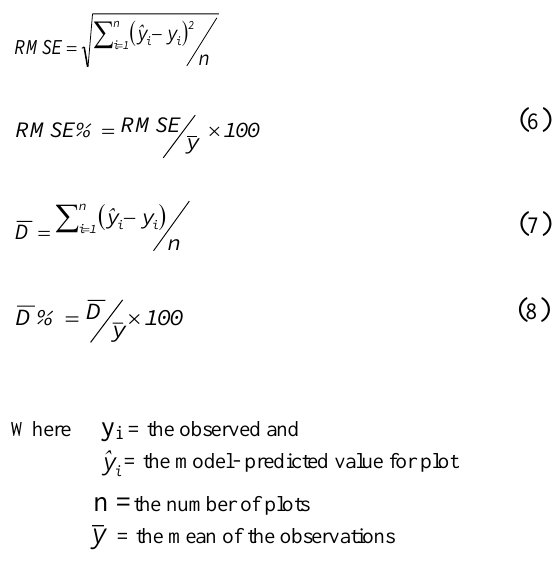
Table.2: The evaluation of the random forest to determine the most appropriate parameter for volume using spectral and auxiliary data